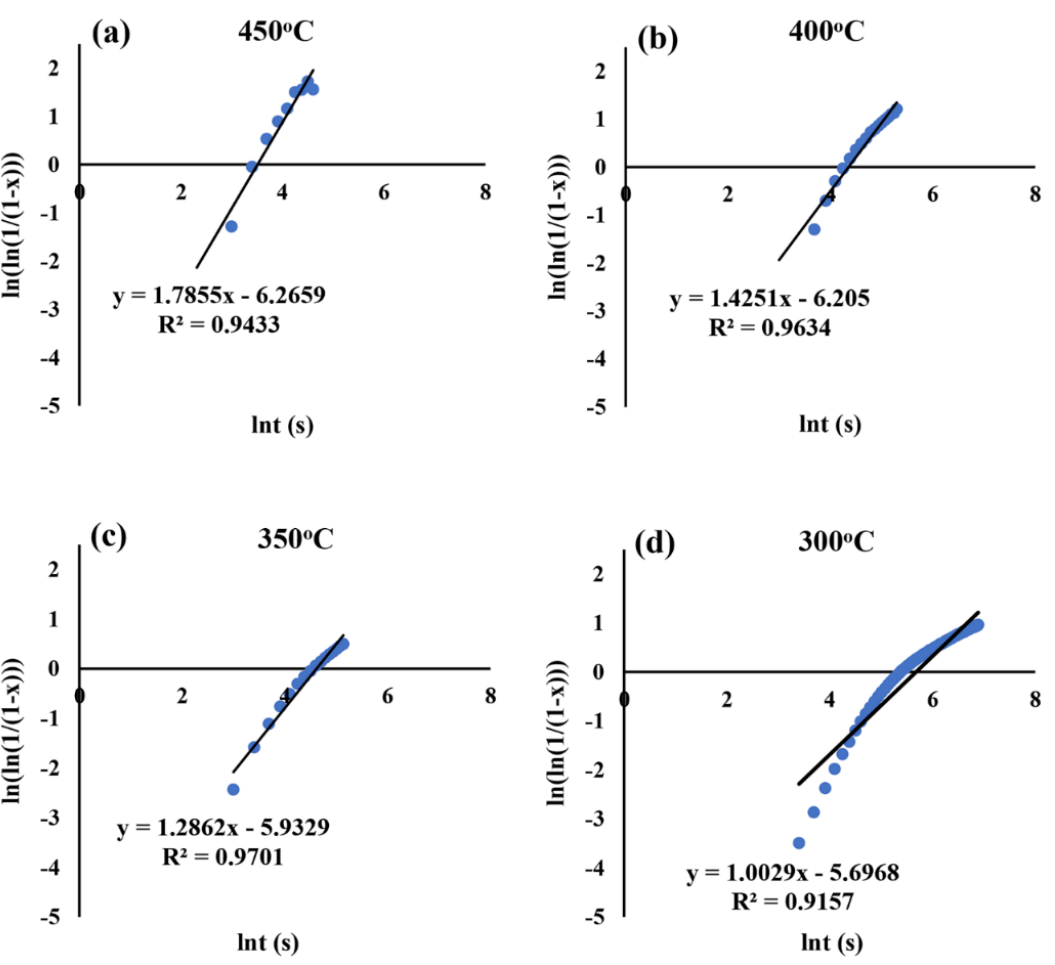
Figure 4. Plots of ln[ − ln(1 − x)] vs. lnt corresponding to dilatation data acquired at various isothermal holding temperatures above M s : ( a ) 450 °C, ( b ) 400 °C, ( c ) 350 °C and ( d ) 300 °C.